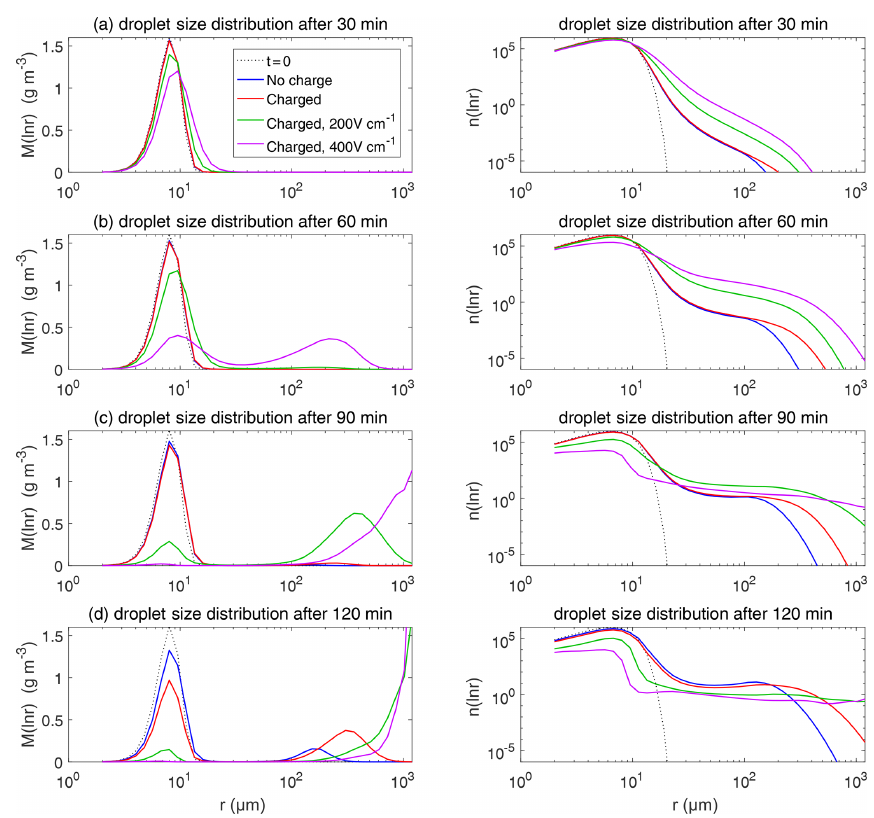
Figure 14. The evolution of the droplet size distribution with initial ¯ r = 6 . 5µm.